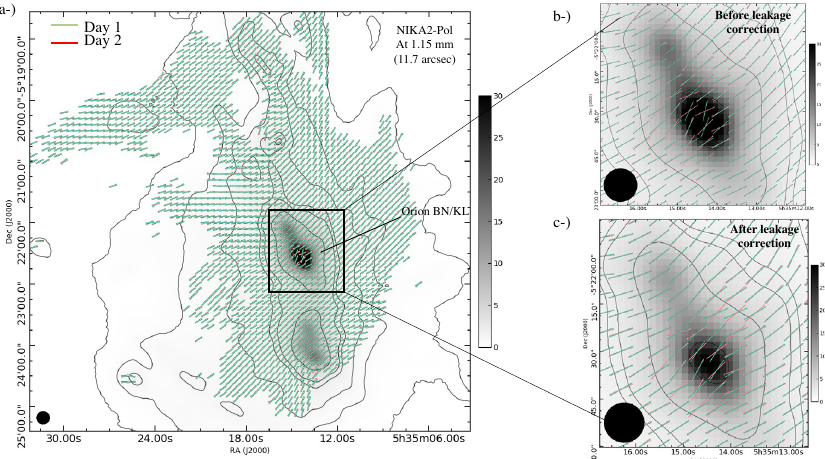
Figure 1. ( a ): B-field vectors from NIKA2-Pol polarization data at positions of significant detections in > 3) on two di ff erent days, day 1 and day 2 (before leakage correction), polarized intensity (i.e., I pol / σ I pol corresponding to the green and red colors, respectively. ( b ): Closeup view of the vicinity of Orion-KL position overlaid with B-field vectors before correcting for instrumental polarization. ( c ) similar to panel b but after correcting for instrumental